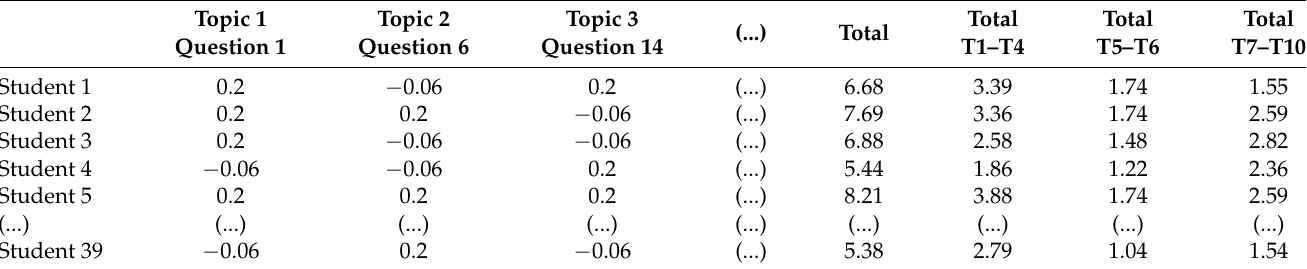
Table 10. Sample of grades by topics and questions. Year 2019–2020.